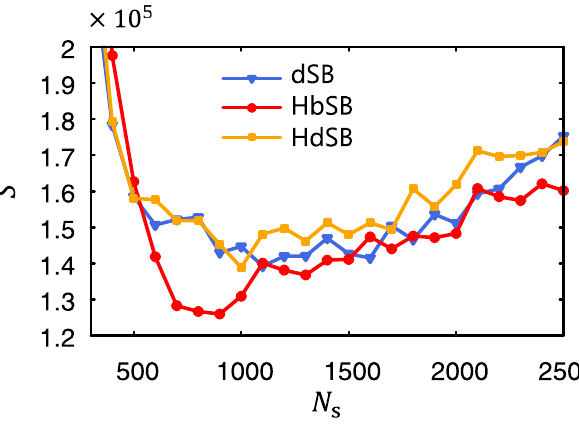
Fig. 4 Comparison of performance for 100 instances of a 700-spin Ising problem. The medians of step-to-solution S for the 100 instances are shown as functions of the number of time steps, N s . Parameters Δ t , c 1 , and γ are the same as in Fig. 1. SB means simulated bifurcation, and b, d, and H denote ballistic, discrete, and heated, respectively.